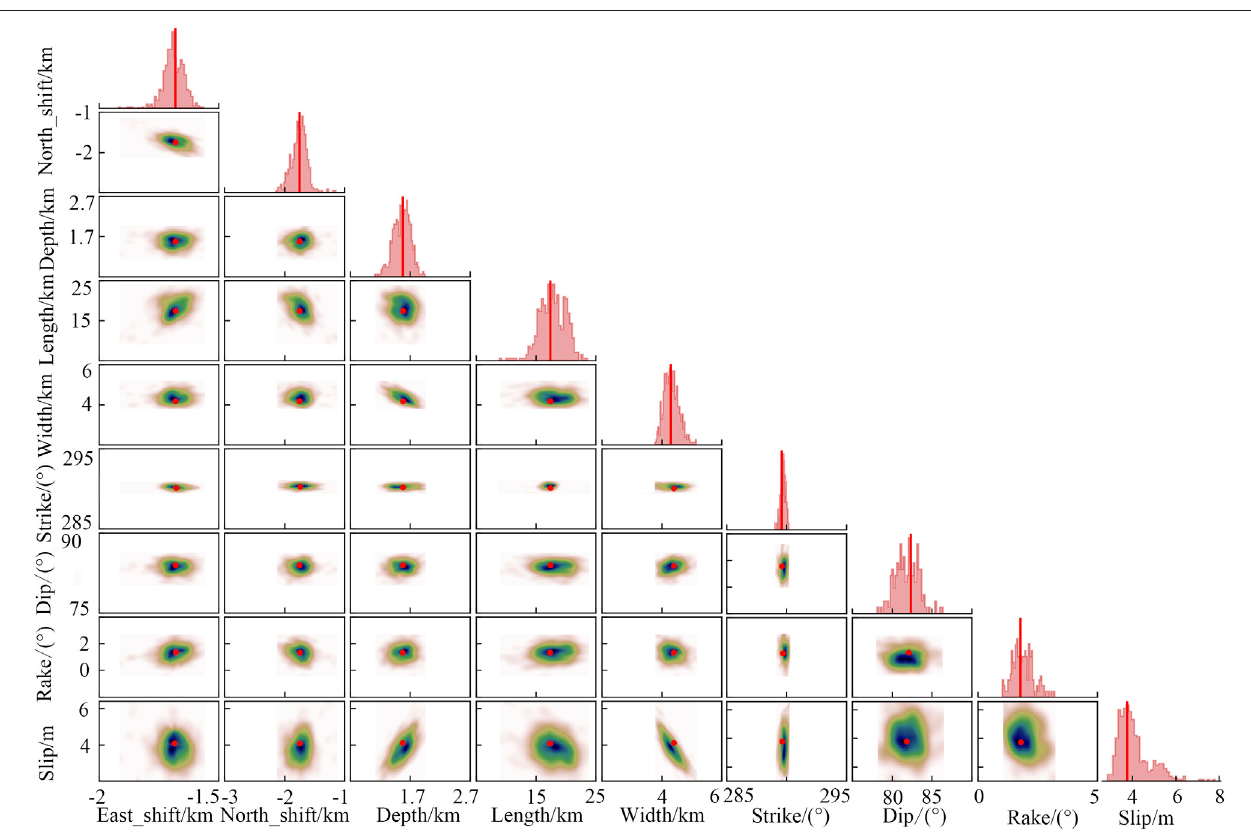
FIGURE 5 | 1D and 2D posterior probability density distributions for the rectangular source of the 2022 Menyuan earthquake. Red lines and red points show the MAP. Cold colors indicate high probability areas.